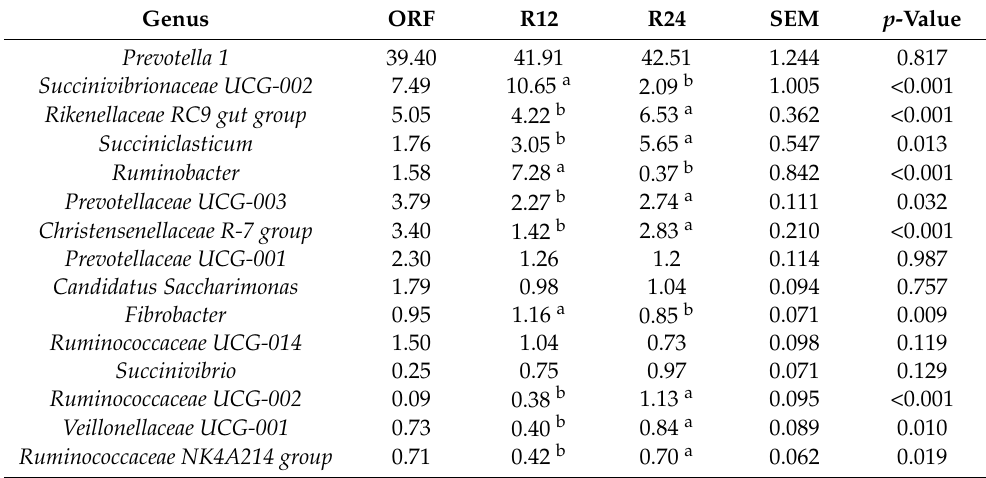
Table 5. Rumen bacterial composition at the genus level as in vitro fermentation